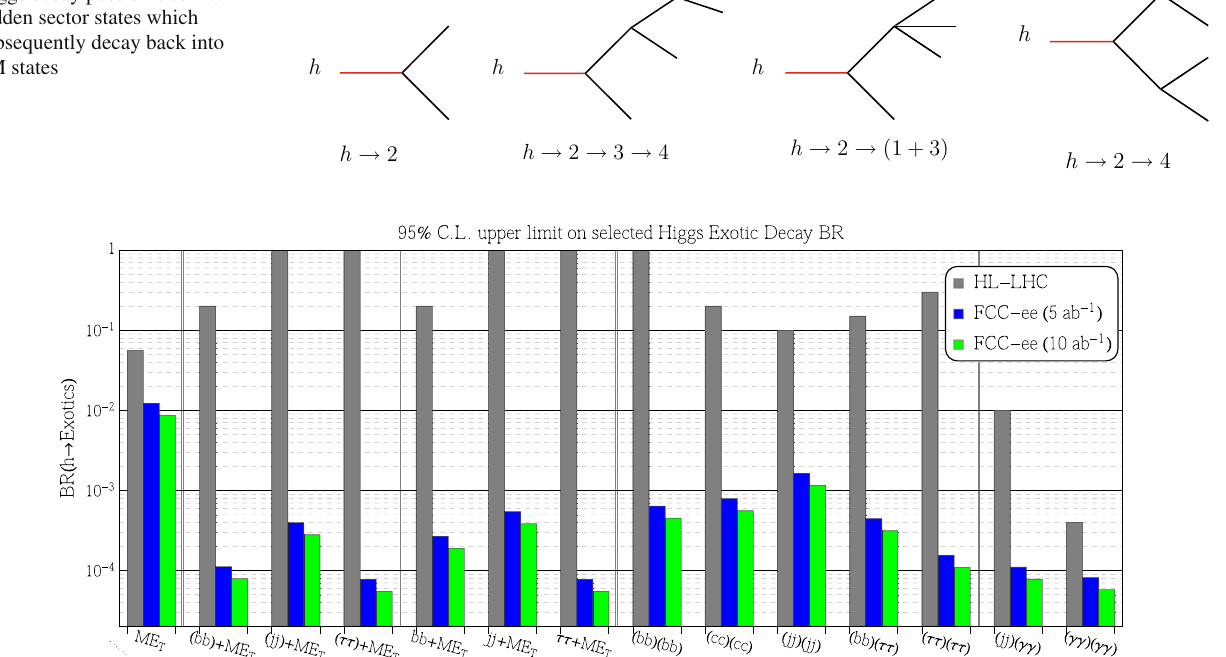
Fig. 15.2 The 95% C.L. upper limit on selected Higgs exotic decay branching fractions at HL-LHC and FCC- ee . This figure is taken from